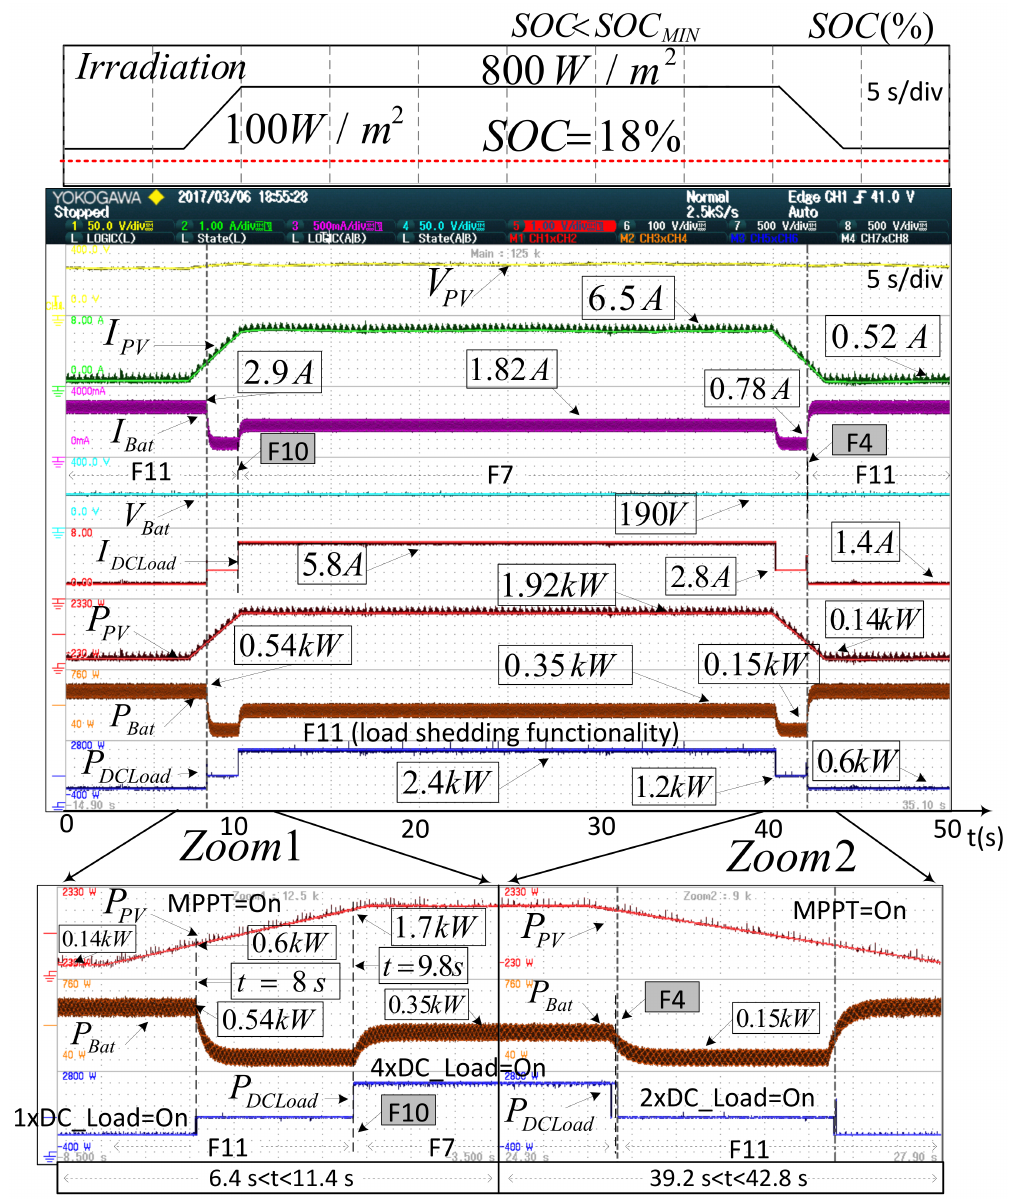
Figure 11. Experiment